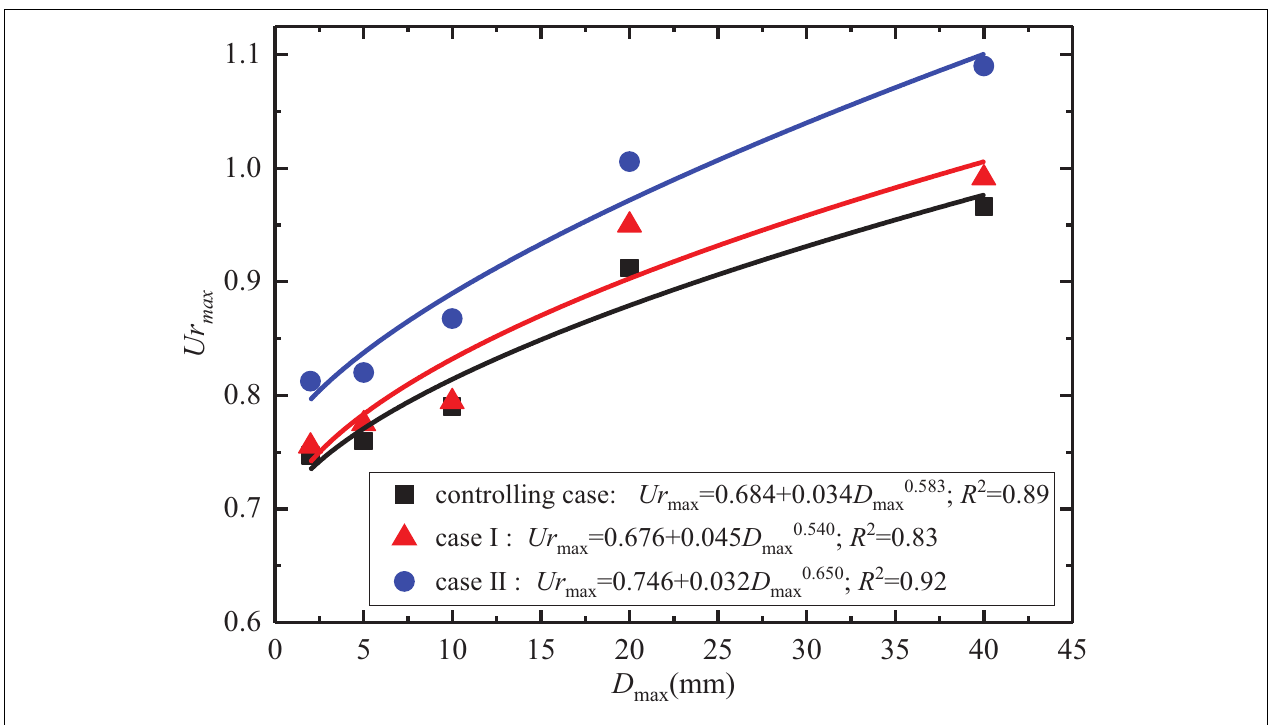
FIGURE 9 | Relationship between Ur max and D max under different operation